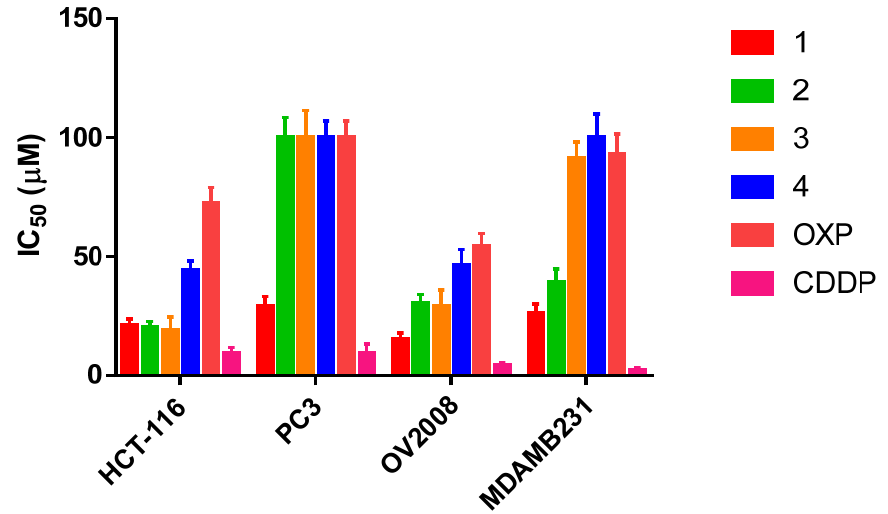
Figure 11. In vitro cytotoxicity of compounds 1 , 2 , 3 , 4 , oxaliplatin (OXP), and cisplatin (CDDP) towards HCT-116, PC3, OV2008, and MDAMB231 cell lines.